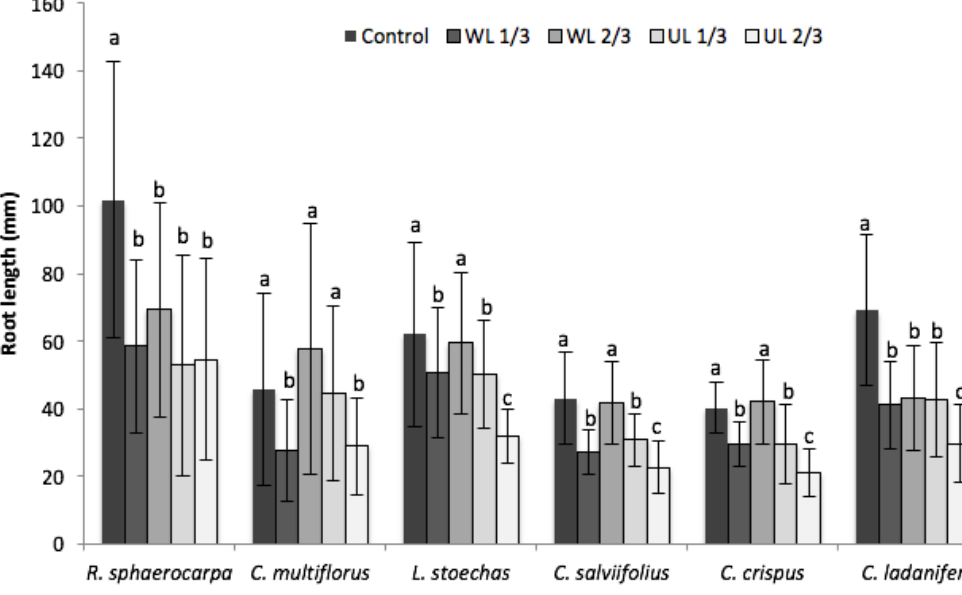
Figure 3. Effect of leaf litter on the root length of the analysed species in the five treatments (C: vermiculite control; WL, washed leaf litter; UL: untreated leaf litter; 1/3: 1.33 dm 3 of vermiculite and 0.66 dm 3 of leaf litter; 2/3: 0.66 dm 3 of vermiculite and 1.33 dm 3 of leaf litter). a, b, c: same letter means no significant difference between treatments ( p > 0.05).